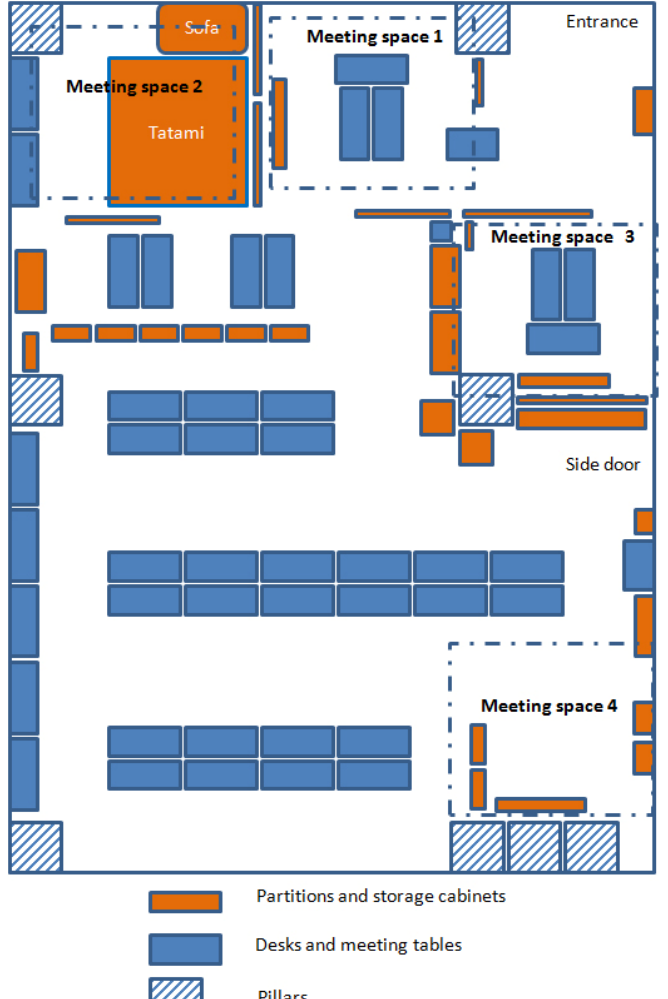
Figure 2. Office layout after the